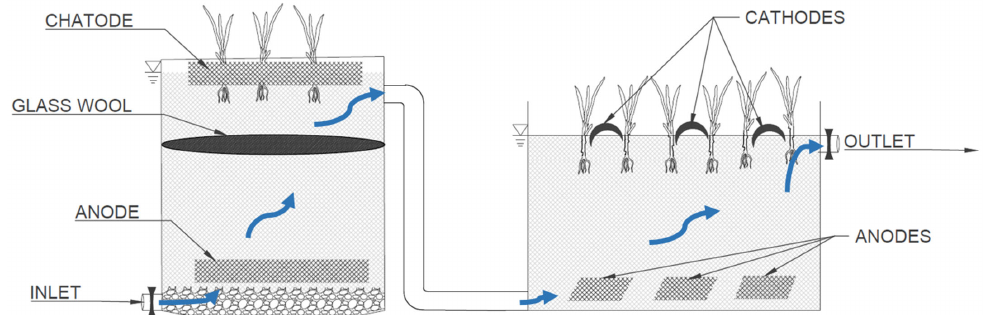
Figure 14. Representation of the alum ‐ sludge ‐ based hybrid CW ‐ MFC with a vertical up ‐ flow system in the first stage and a horizontal subsurface flow system in the second stage ( adapted from Ren et al. (2021) [37]).